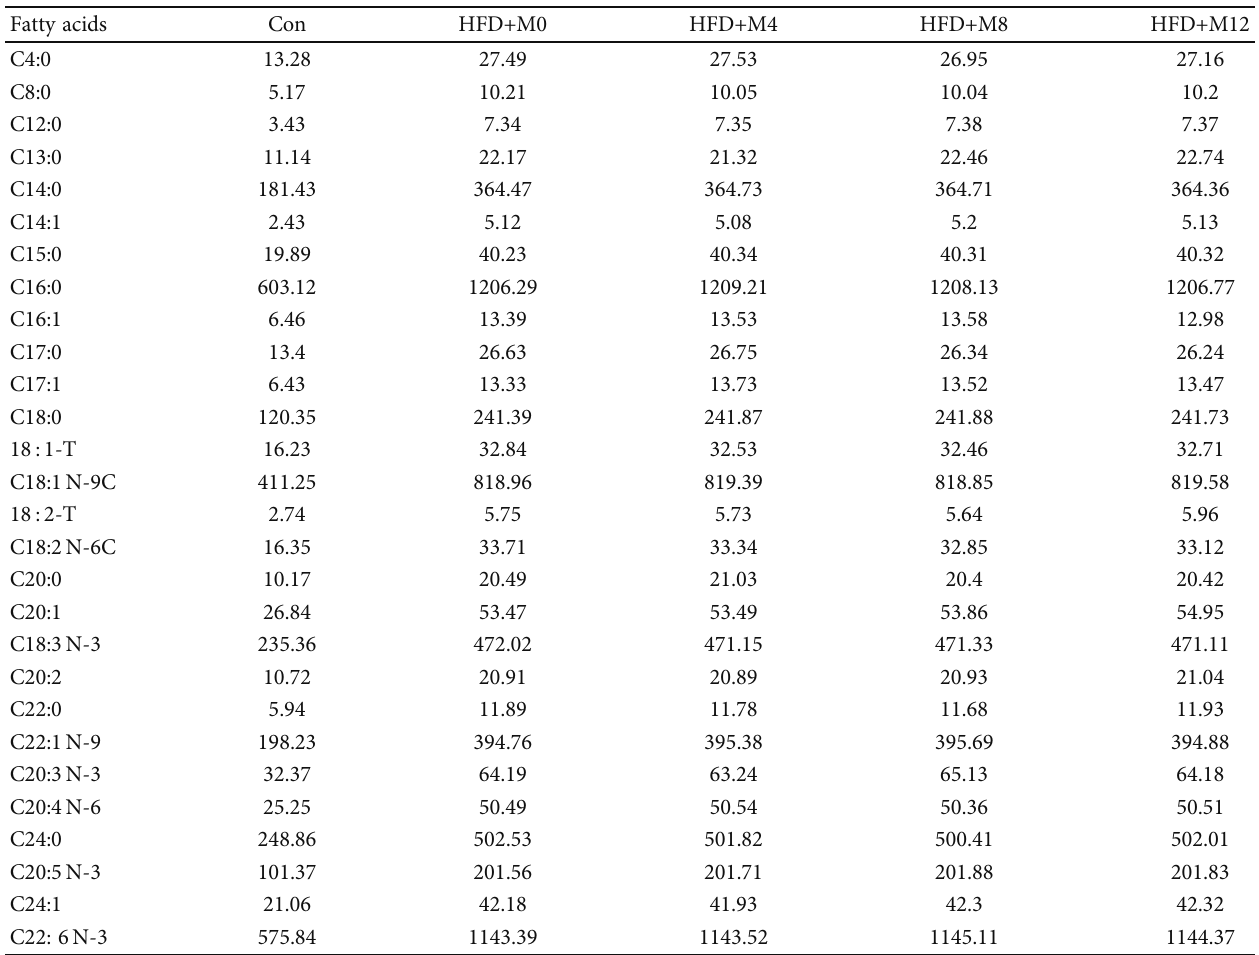
Table 3: Contents of fatty acids of experimental diets